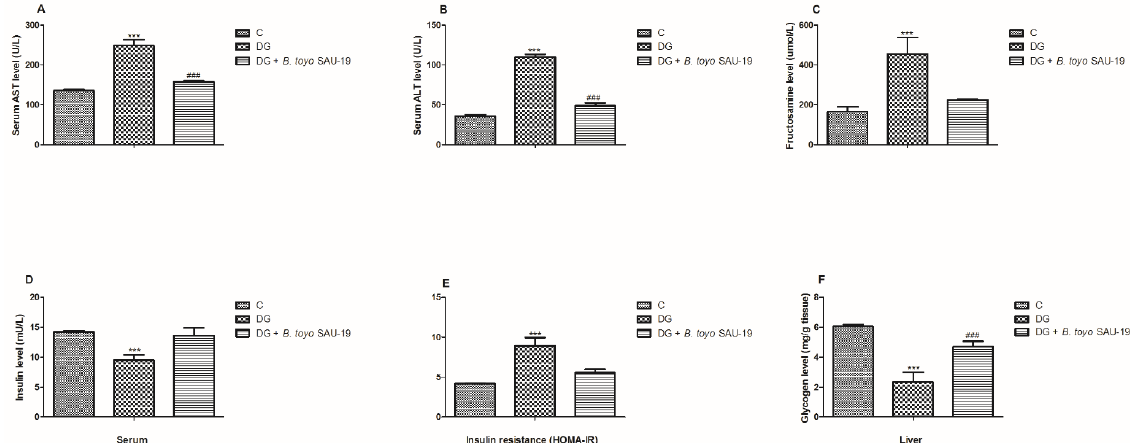
Figure 3. Effects of Bacillus toyonensis SAU-19 on biochemical parameters in HFD/STZ-induced T2DM mice. ( A ) Levels of AST in blood serum (U/L). ( B ) Levels of ALT in blood serum (U/L). ( C ) Levels of fructosamine in serum ( µ mol/L). ( D ) Insulin level in the blood serum (mU/L). ( E ) Insulin resistance indicator. ( F ) Glycogen content in liver (mg/g tissue). Values are shown as mean ± Sd. *** p < 0.05, DG compared with the control (C) and B. toyo SAU-19 groups. ### p < 0.05, B. toyo SAU-19 compared with the control (C) group ( n = 6). AST—Aspartate Aminotransferase, ALT—Alanine Aminotransfer- ase.